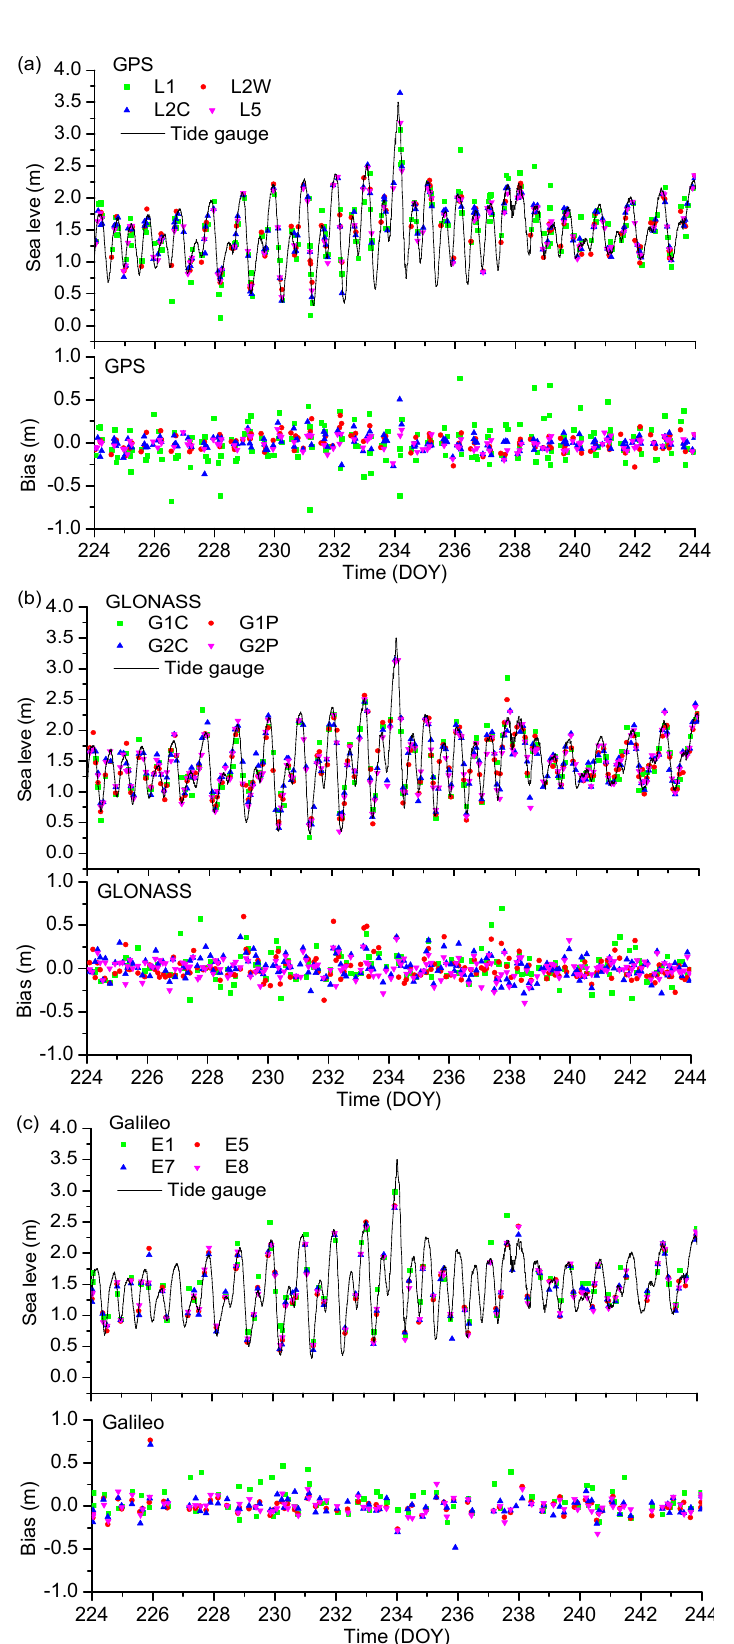
Figure 4. Sea level retrievals and sea-level measurements and biases between them for ( a ) GPS; ( b ) GLONASS; ( c ) Galileo.